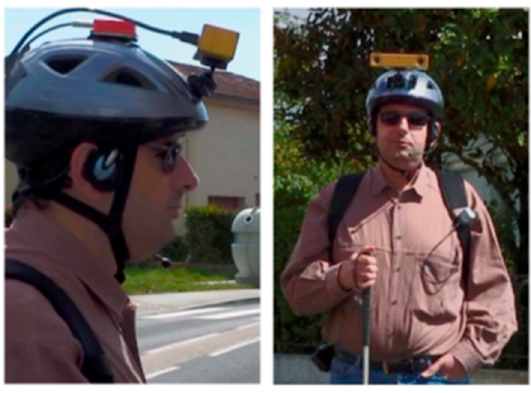
Figure 6. An assistive device for blind people based on a map matching approach and artificial vision